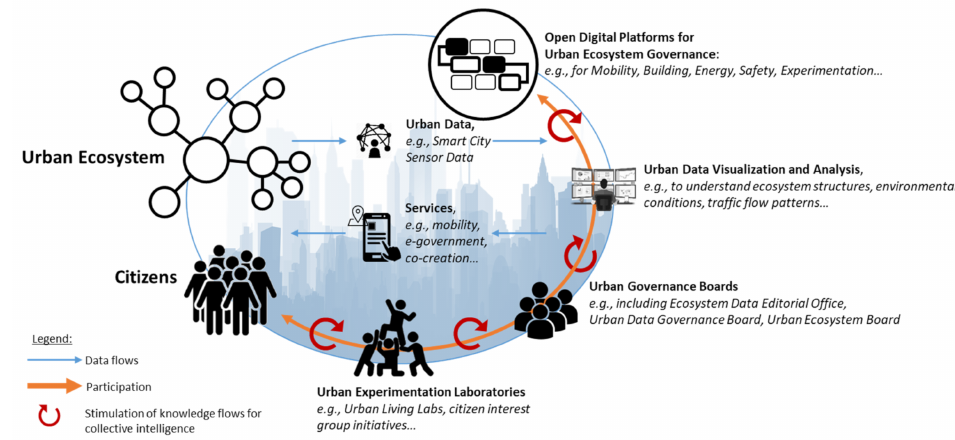
Figure 2. Open digital platforms supporting collective intelligence and organizational models for urban